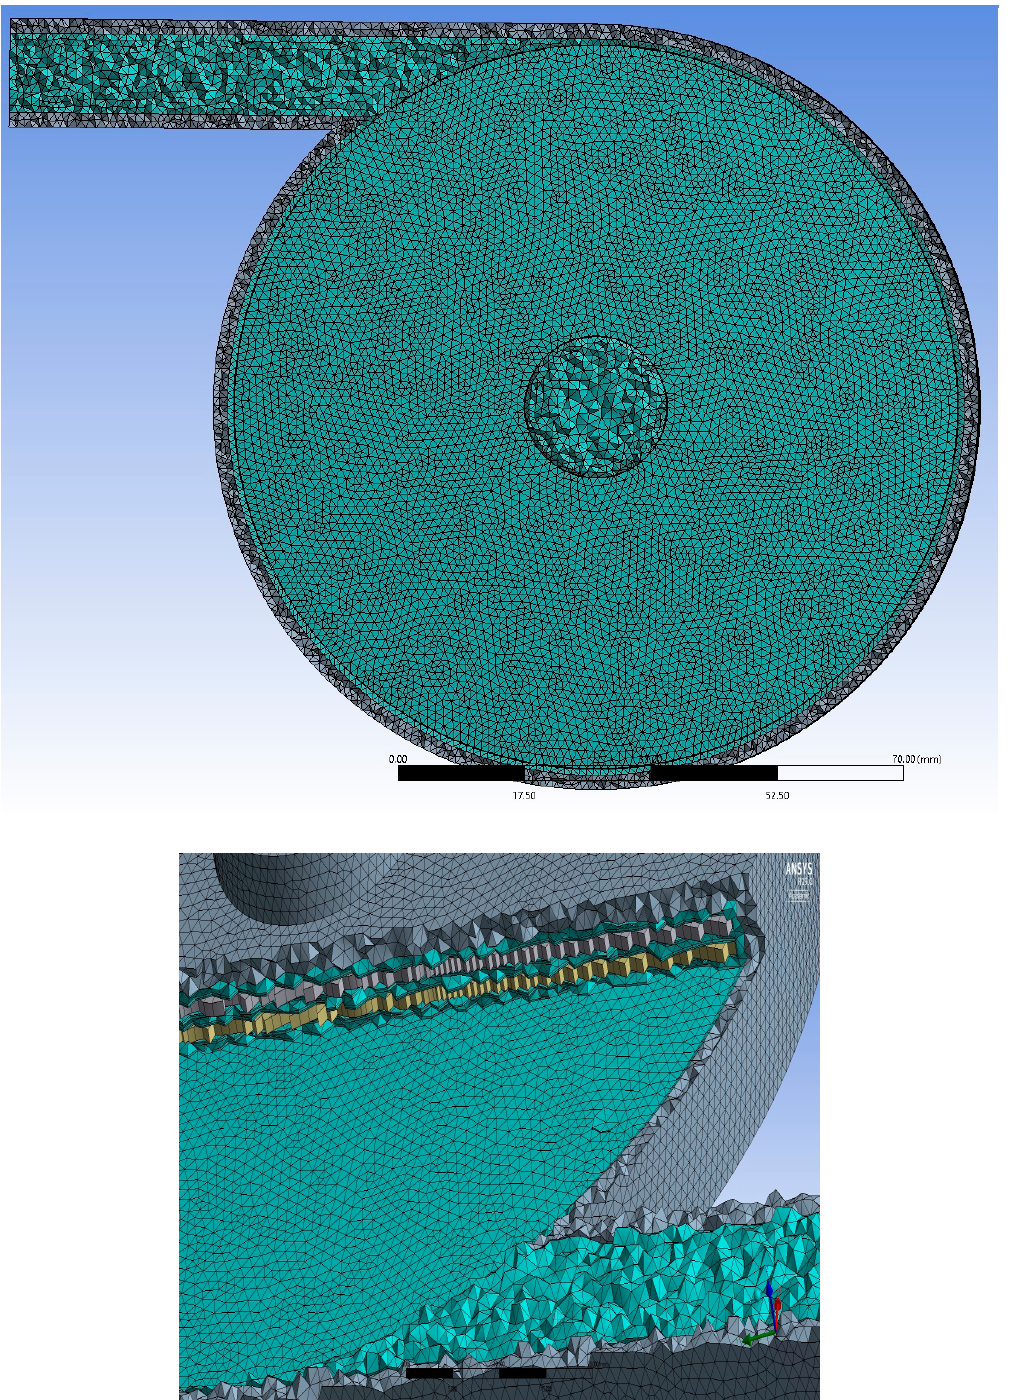
Figure 4. Unstructured generated mesh for 3D geometry of a Tesla turbine.